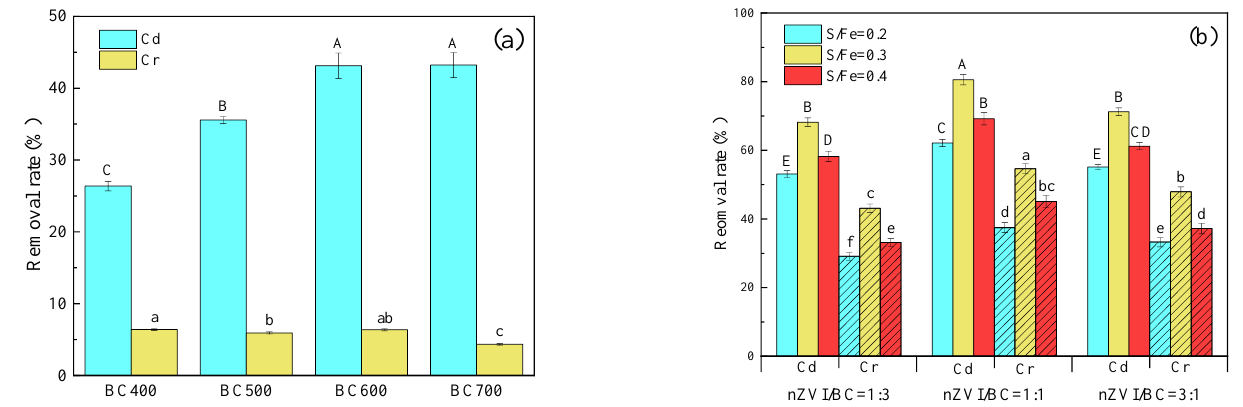
Figure 1. The removal rates of Cd(II) and Cr(VI) by ( a ) BC and ( b ) BC-SnZVI. Different letters on bars indicate significant differences at p < 0.05 within the same heavy metal (Cd(II) or Cr(VI)) treatments.